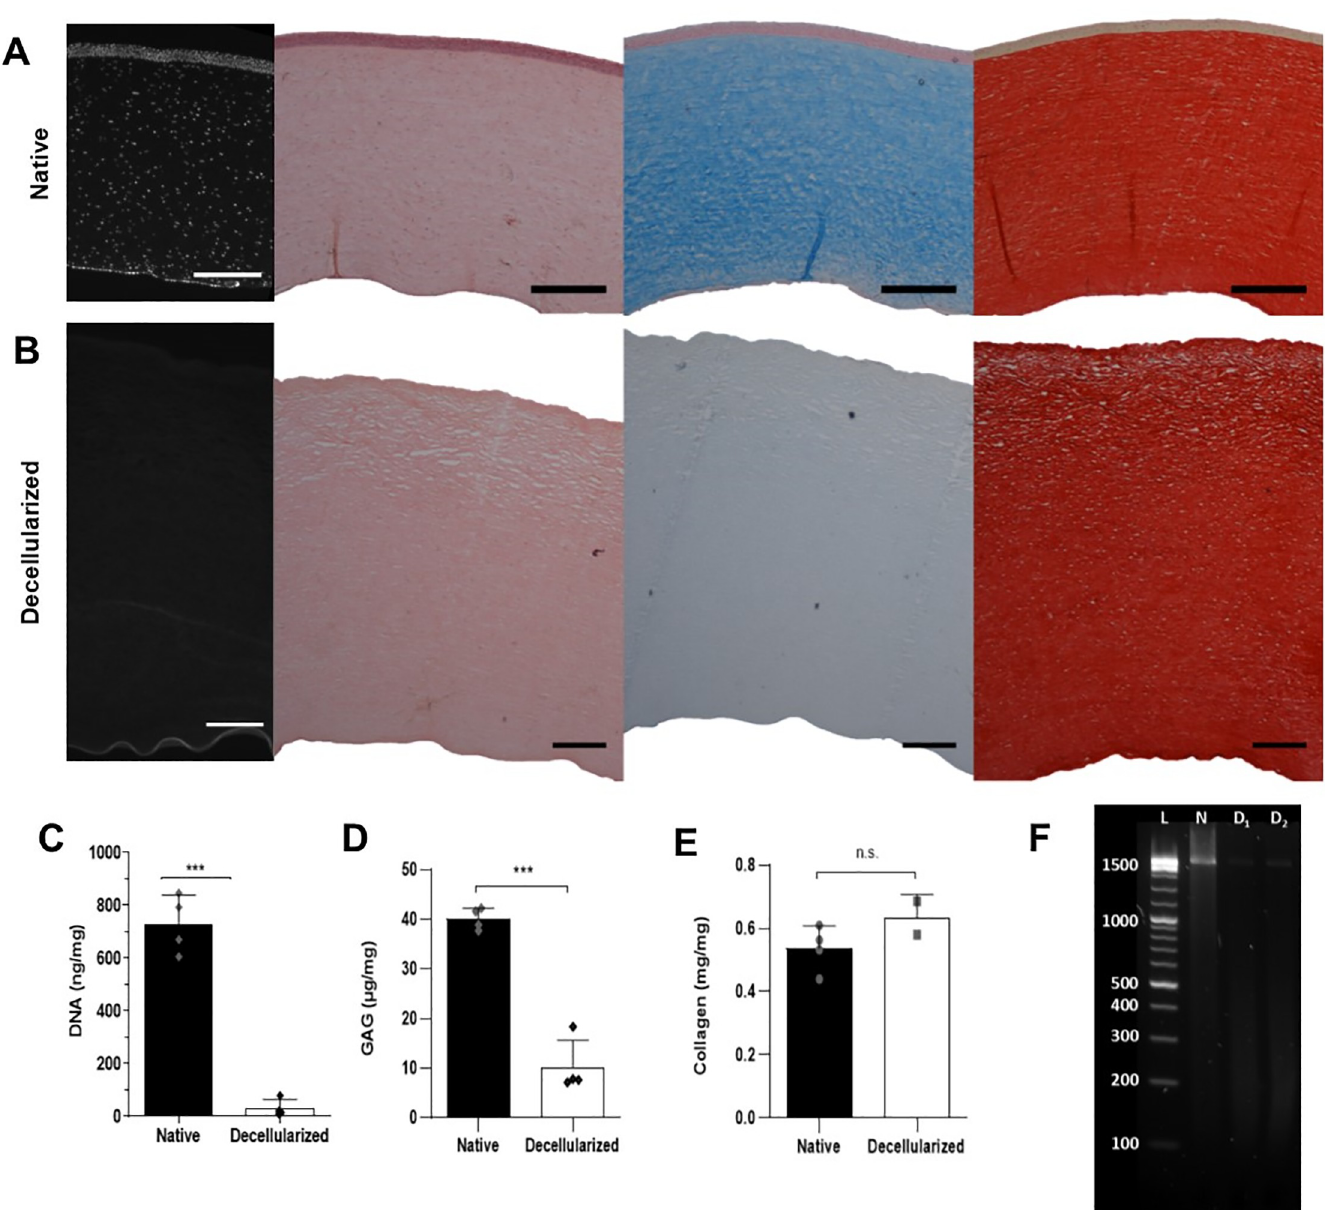
Fig 1. Evaluation of porcine cornea decellularization. A) Native cornea and B) decellularized scaffold, from left to right stained with, DAPI, H&E, Alcian blue or picrosirius red. Black scale bar = 500 μ m, white = 250 μ m. Quantification of native cornea and decellularized scaffold C) DNA, D) glycosaminoglycans and E) Collagen. p � < 0.05, p �� < 0.01, p ��� < 0.001. F) Agarose gel electrophoresis of DNA from native cornea (N) and decellularized scaffold (D1 and D2). Ladder